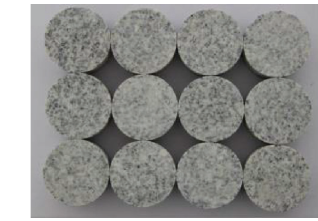
Figure 3: Test sample.